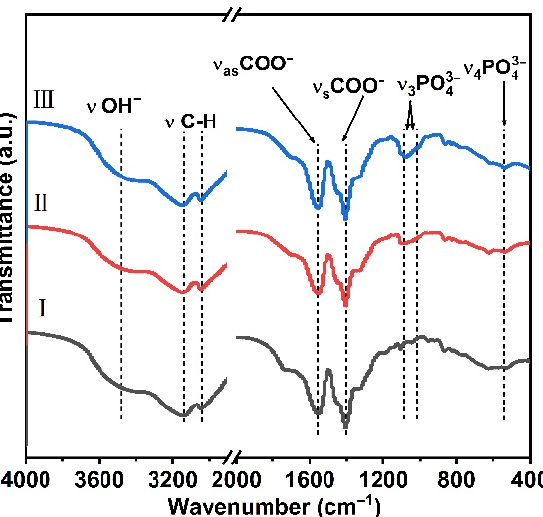
Figure 2. Fourier transform infrared spectroscopy spectra of PAA-Ca (Eu) nanoclusters with differ- ent PO 43 − concentration. Ⅰ – Ⅲ are 0 mM, 2 mM, and 7.5 mM.